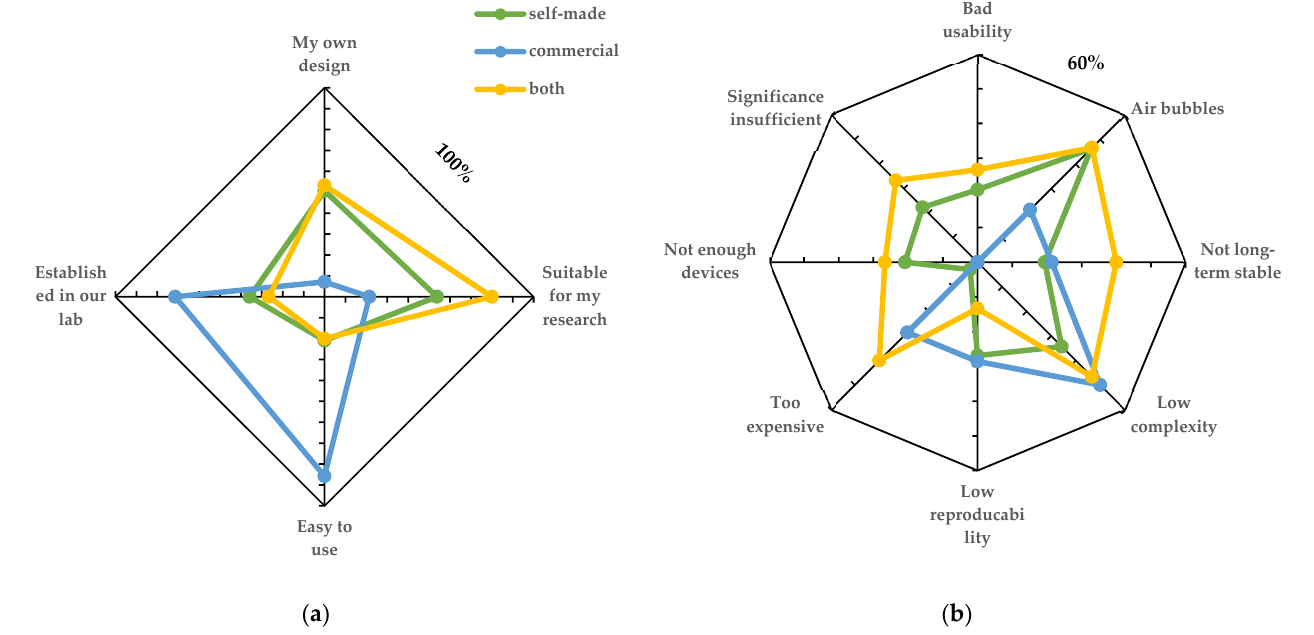
Figure 2. Assessment from researchers currently using OoC technology (group A) regarding ( a ) advantages and ( b ) drawbacks of their current platforms.